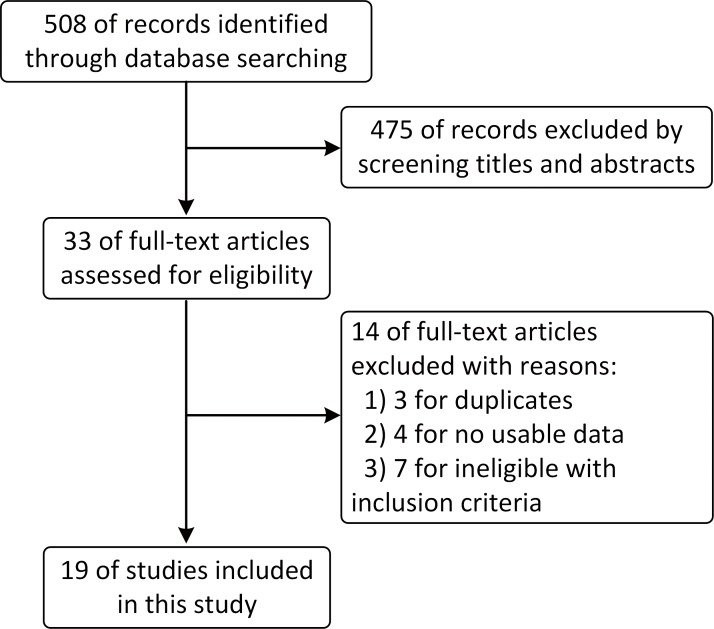
Flowchart of this systematic review.